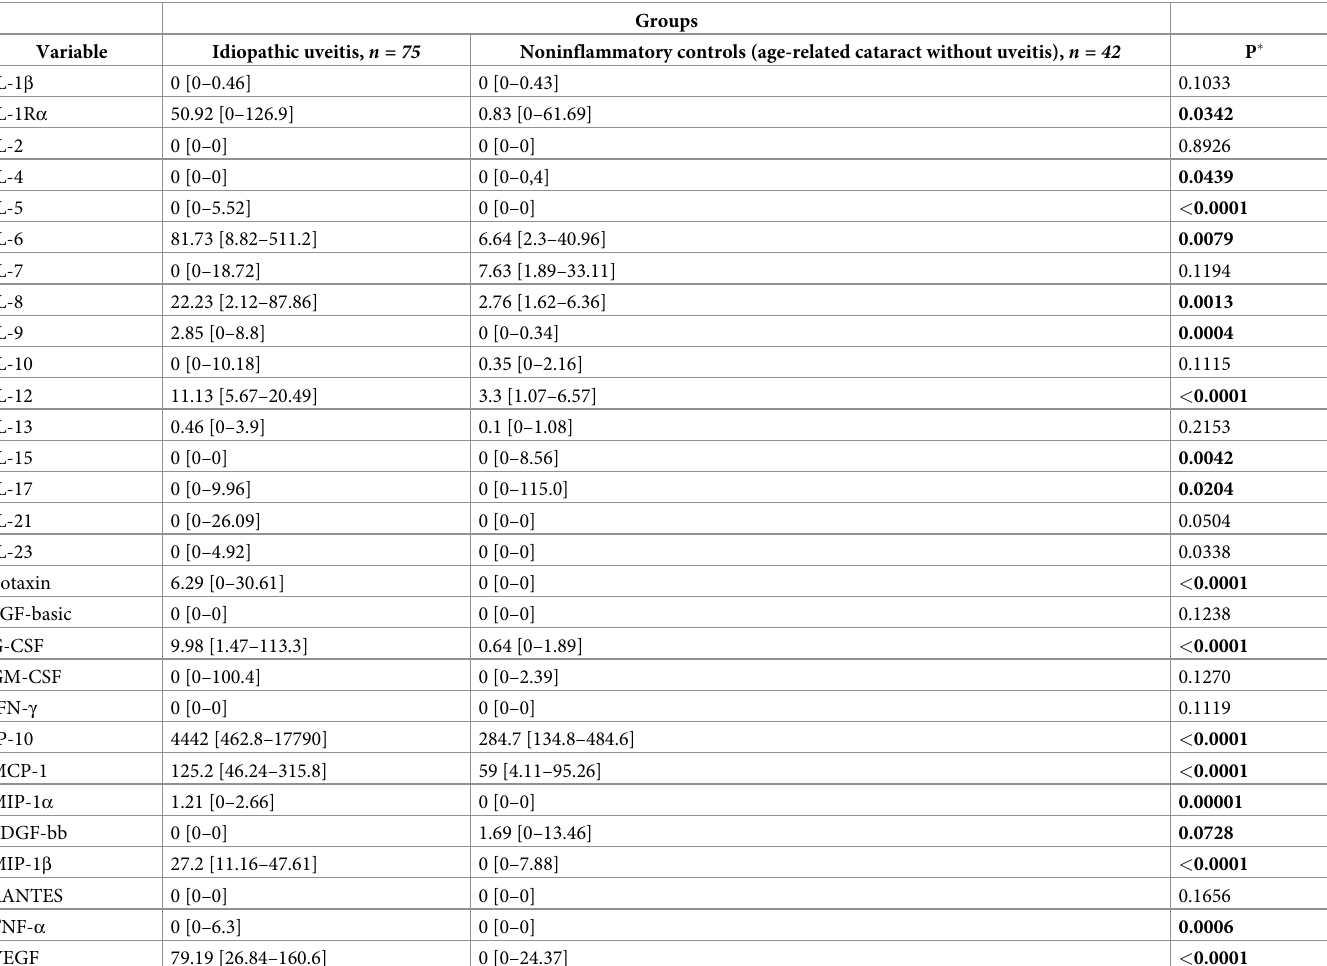
Table 2. Concentrations (pg/ml) of immune mediator expression in aqueous humor (AH) from 75 samples of patients with idiopathic uveitis and 36 samples of noninflammatory controls patients (age-related cataract). n = patients number.